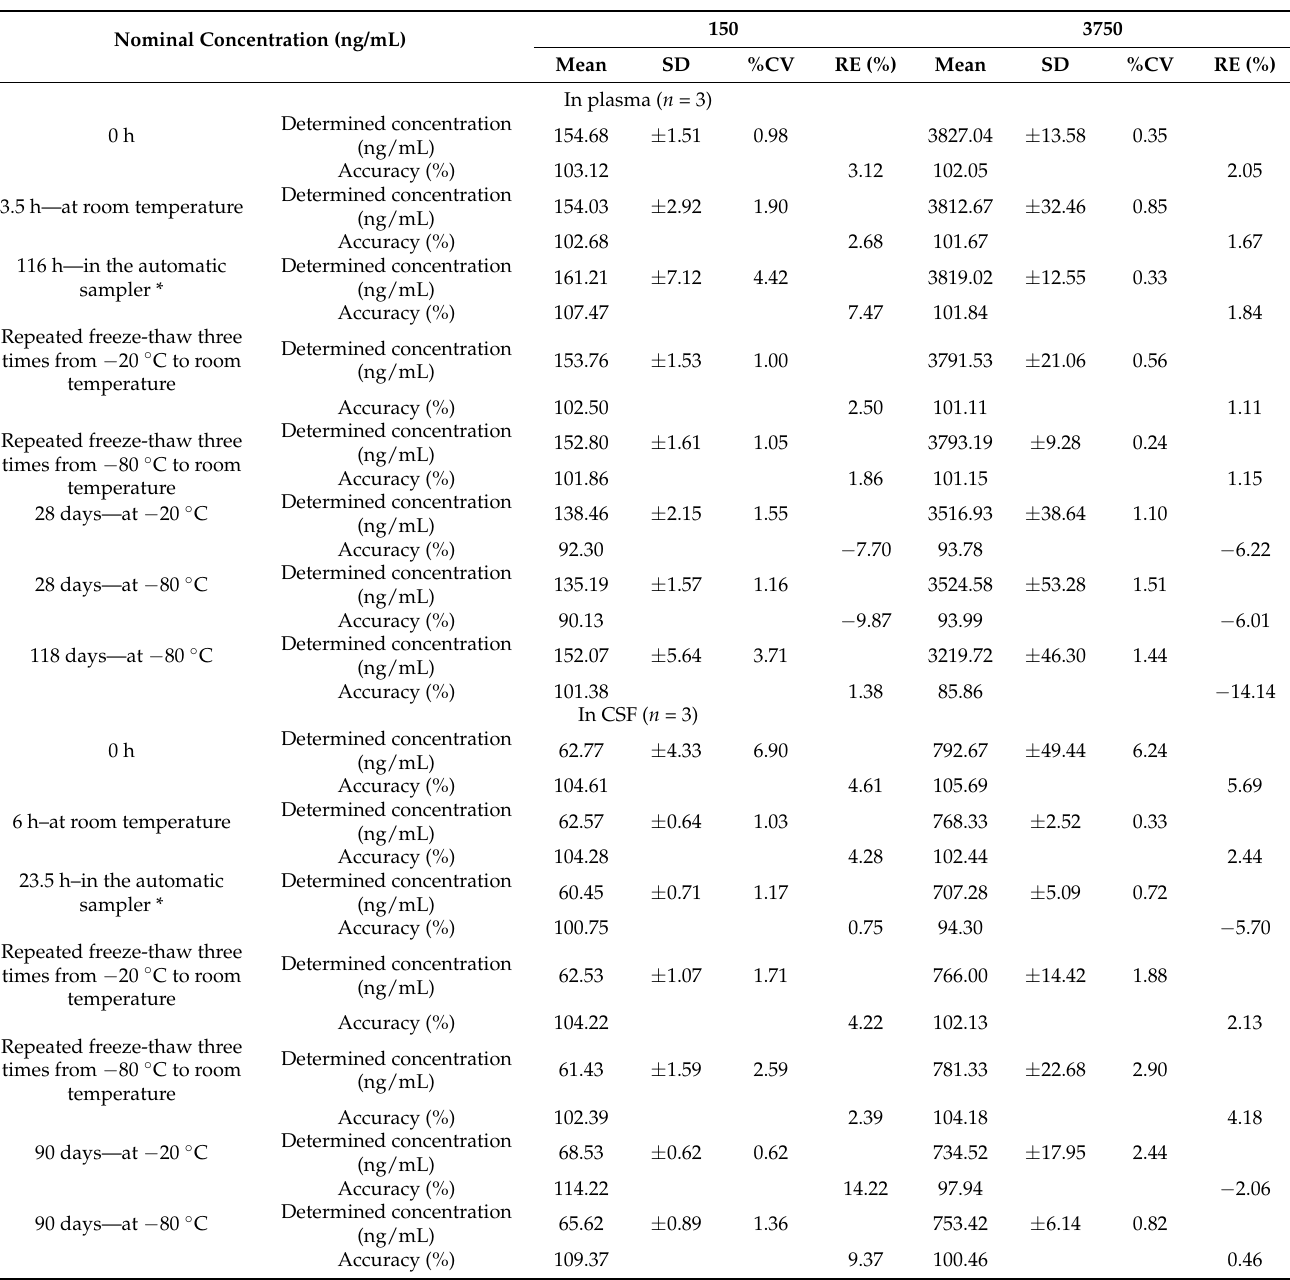
Table 4. Sample stability